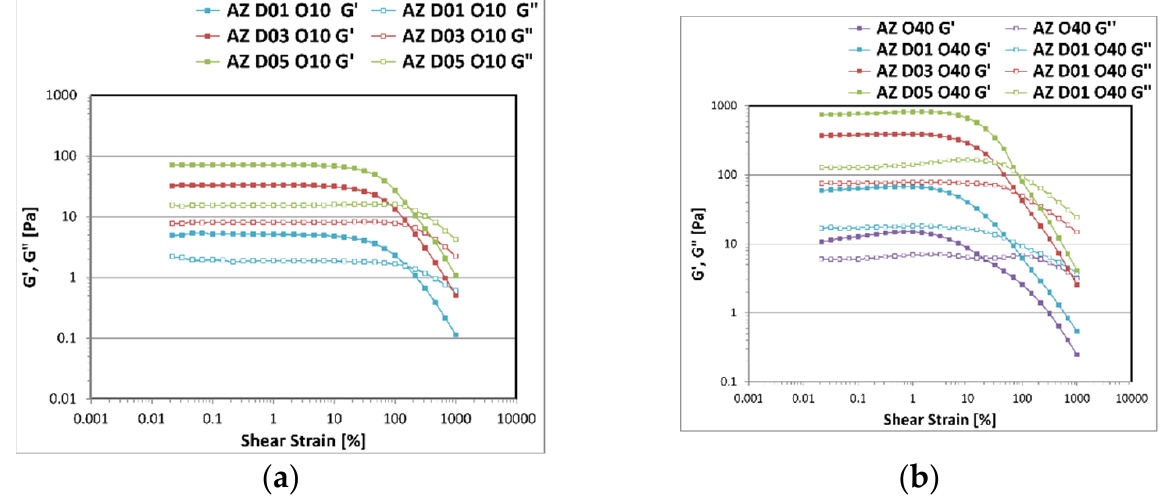
Figure 6. Storage G’ and loss G’’ moduli trend as a function of the oscillation strain measured for the emulsions prepared with A-Z associations (1:1) and increasing concentration of D (0.1–0.3–0.5% w / w ) with 10% w / w ( a ) and 40% w / w of oily phase ( b ).